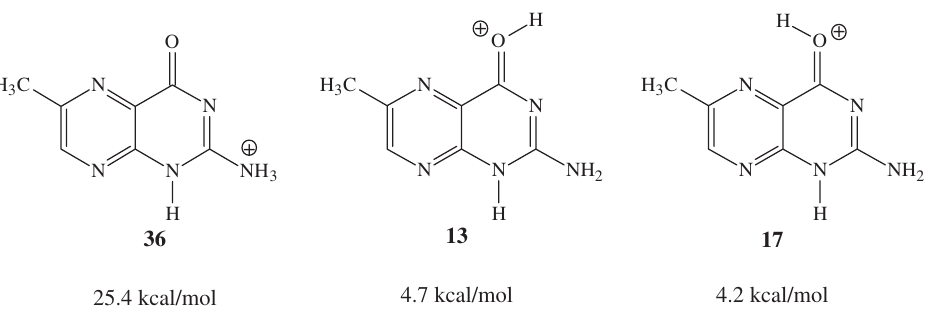
Figure 10 Relative calculated energies of pterins resulting from the non-ring protonation of the α , β -unsaturated lactam structure, 4